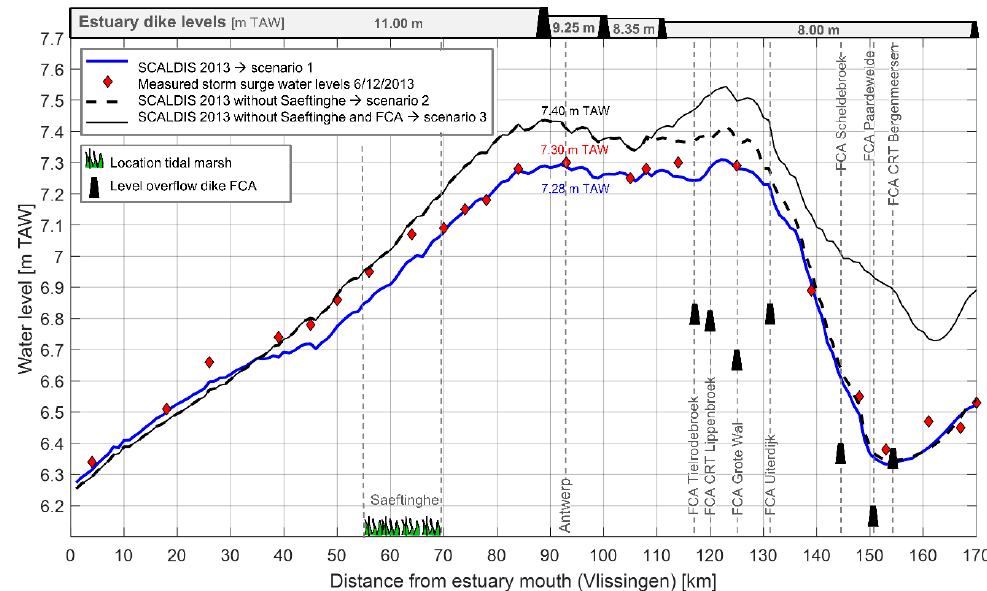
Figure 7. Water levels scenario simulations SCALDIS 2013 with indication of flood protecting dike and